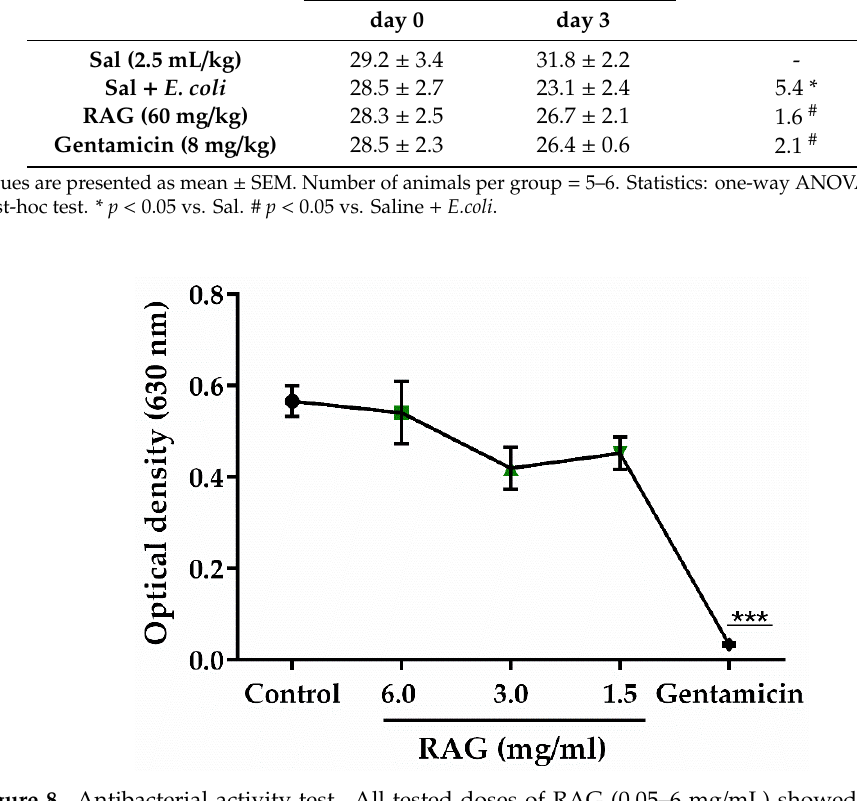
Figure 8. Antibacterial activity test. All tested doses of RAG (0.05–6 mg / mL) showed absence of inhibiting growth of E. coli . The graph shows only the doses of 6, 3, and 1.5 mg / mL of RAG. The standard antimicrobial drug, gentamicin, shows a significant inhibition on E. coli growth. Data shown are means ± SEM from three independent experiments performed under similar conditions. *** p < 0.001 vs. control. Statistics: one-way ANOVA with Dunnett’s multiple comparisons